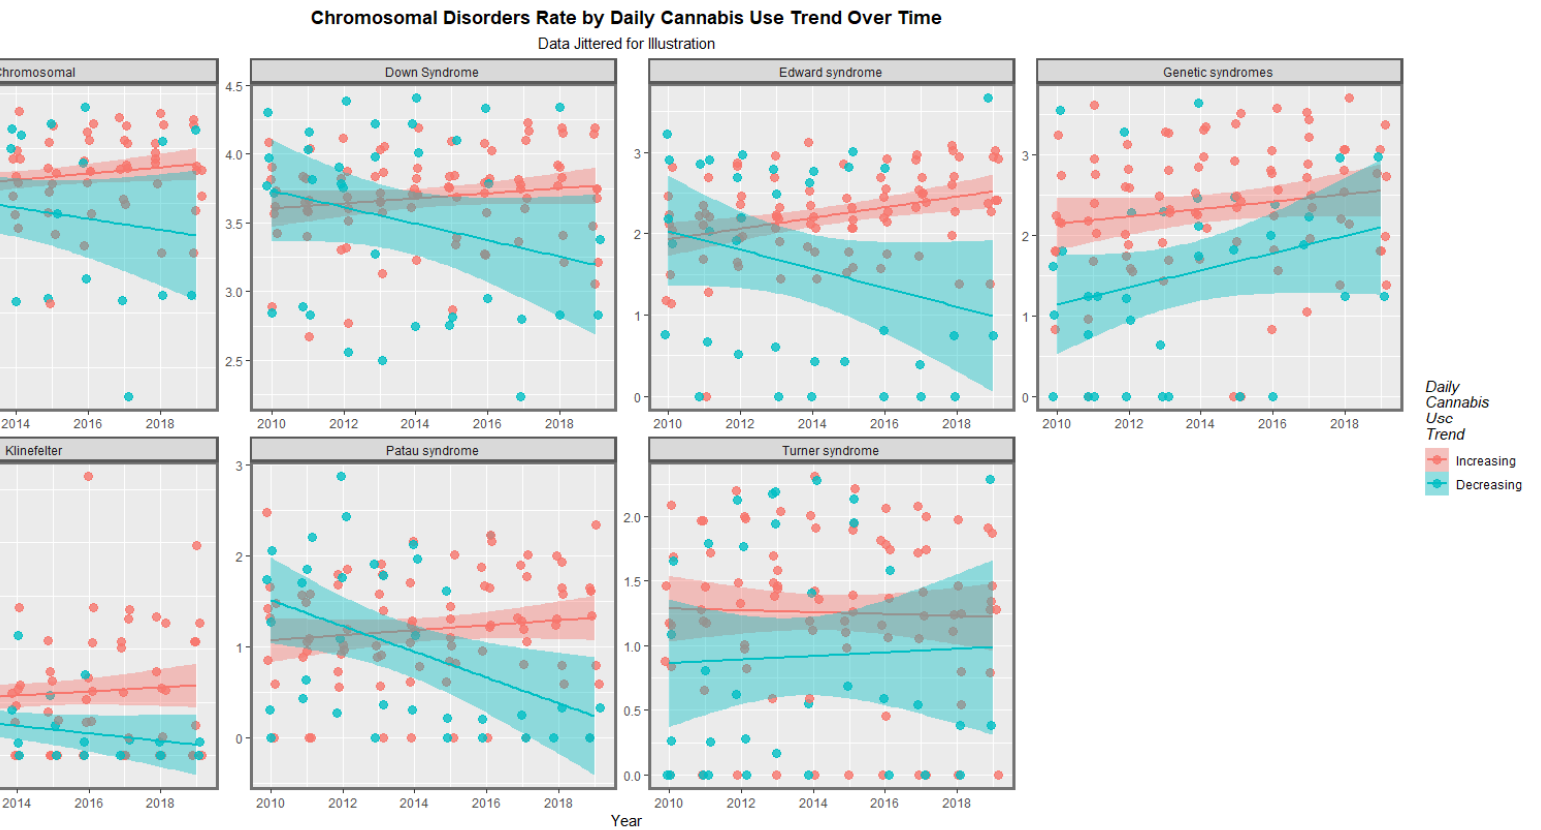
. Figure 8. Log rates of chromosomal disorders over time by category of daily cannabis use by anomaly (see Methods section for details of assignment).